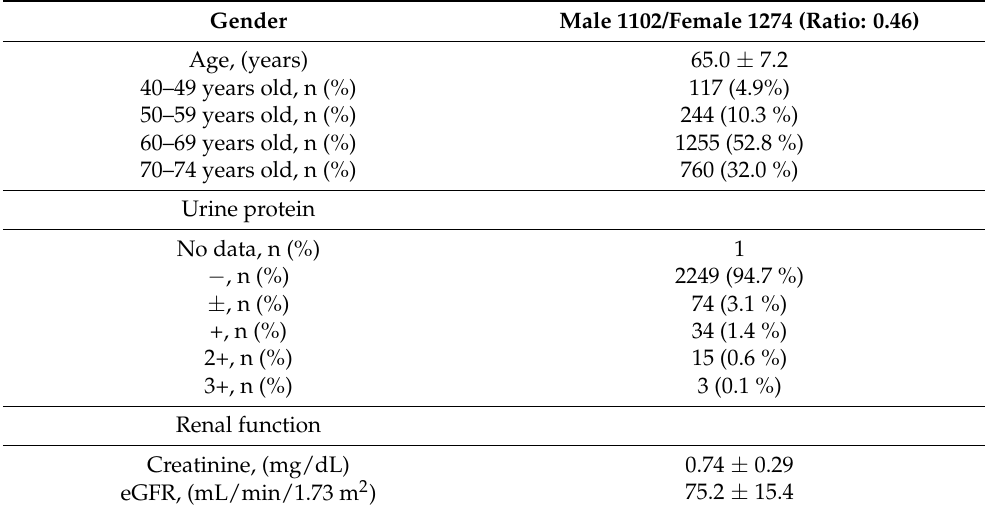
Figure 2. Changes in the number of high-risk subjects for advanced renal dysfunction. The orange bar shows the number of high-risk subjects in each year. Table 1. Baseline characteristics of